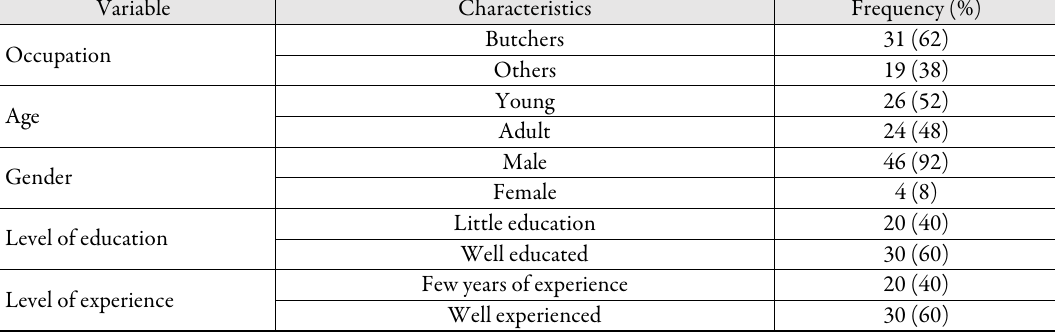
Table 3. Demographic characteristics of the respondents at Ikpa slaughterhouse